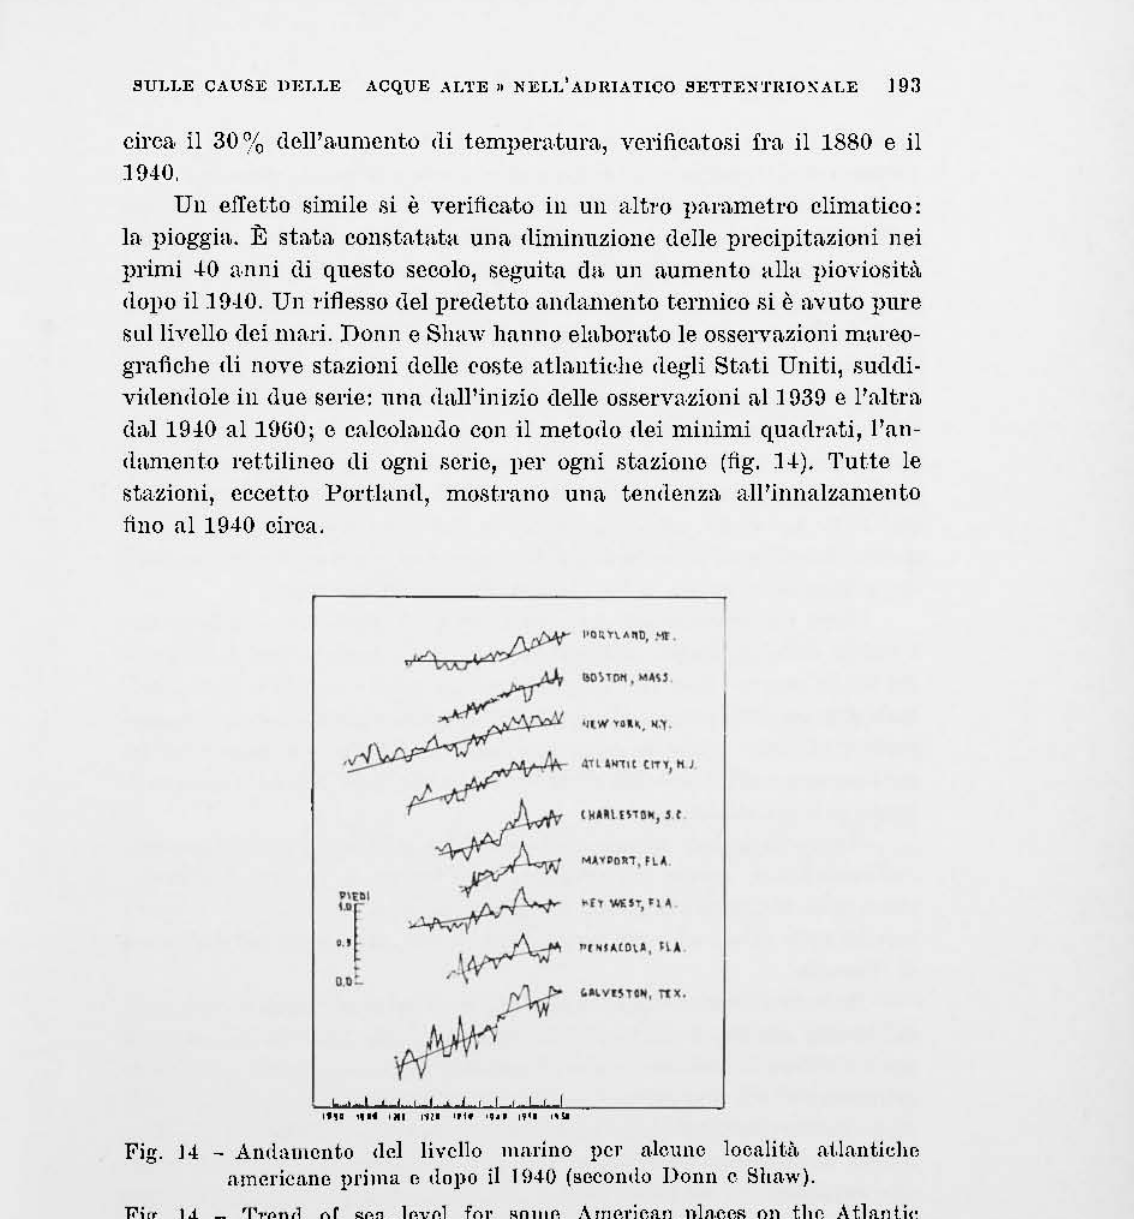
Fig. 14 AIlIlalHento ,Ici livello marino pc!" a\eune loealit,t\ at.lantiche americane prima e ,lopo il 1\J40 (secoIlIlo Donn c Shaw). Fig. 14 _ 'l'l'end or sea level for some Ameriean plaees on the Atlantic seallonl befo!"n allll after 1940 (after Donn and